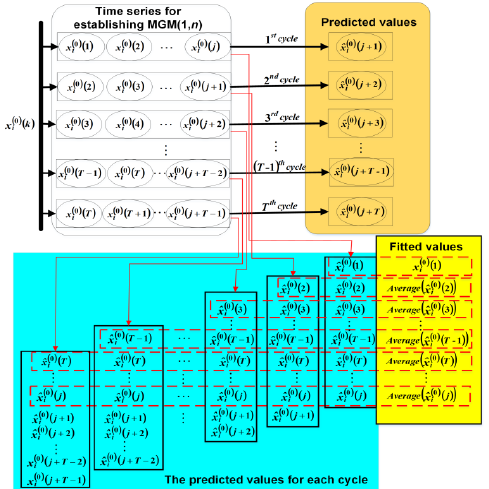
Figure 1. Schematic diagram of the improved Multivariate Grey Model (IMGM (1, n )). In the IMGM (1, n ), based on the establishing process of MGM (1, n ), the rolling update of the modelling data is performed by adding the actual value corresponding to the previous step of the current prediction point and removing the first one in the previous modelling data to achieve the dynamic addition of new information. The modelling data is updated every time the model outputs one predicted value.